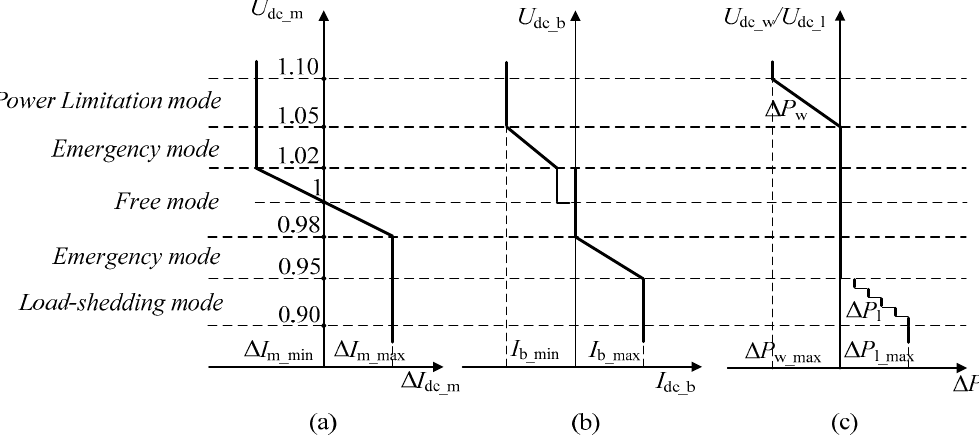
Figure 2. Basic principle of operation mode-based sectional coordinated control strategy for DC microgrid in forest: ( a ) Biomass power generation unit; ( b ) Energy storage unit; ( c ) Wind power unit/Load.